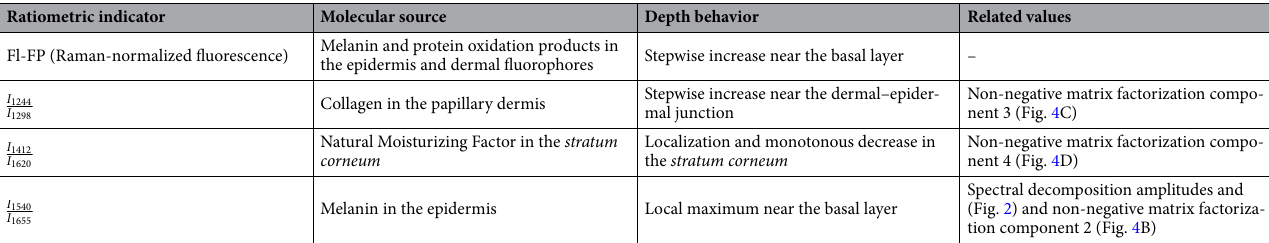
Table 2. Summary of simple ratiometric values used in the work, their molecular sources and depth